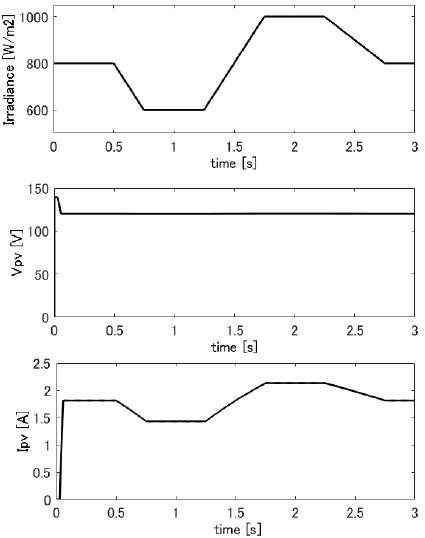
Figure 16. Responses of the proposed MPPT control with the varying irradiance.